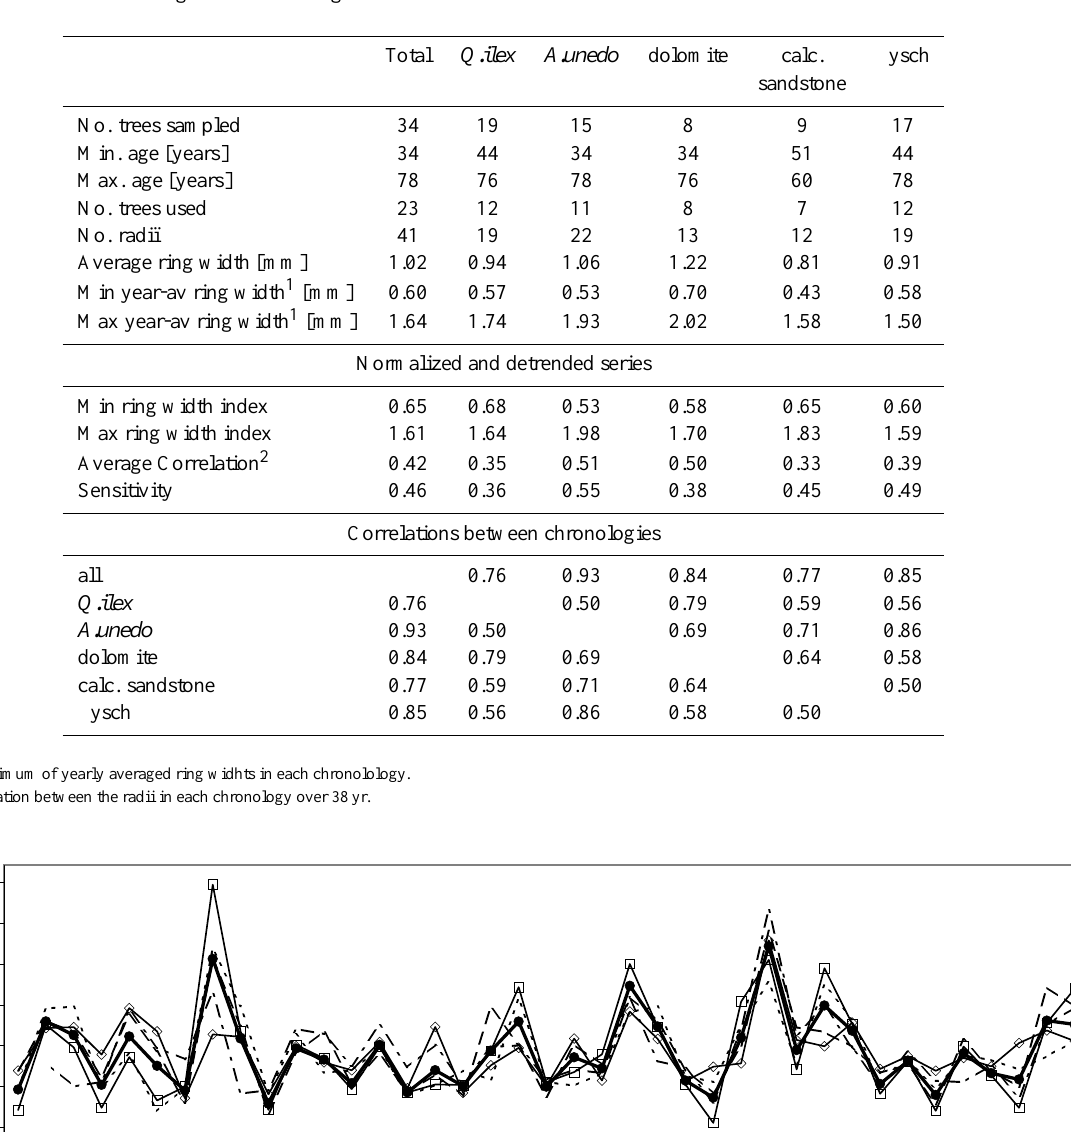
Table 1. Base statistics of the ring-width chronologies.